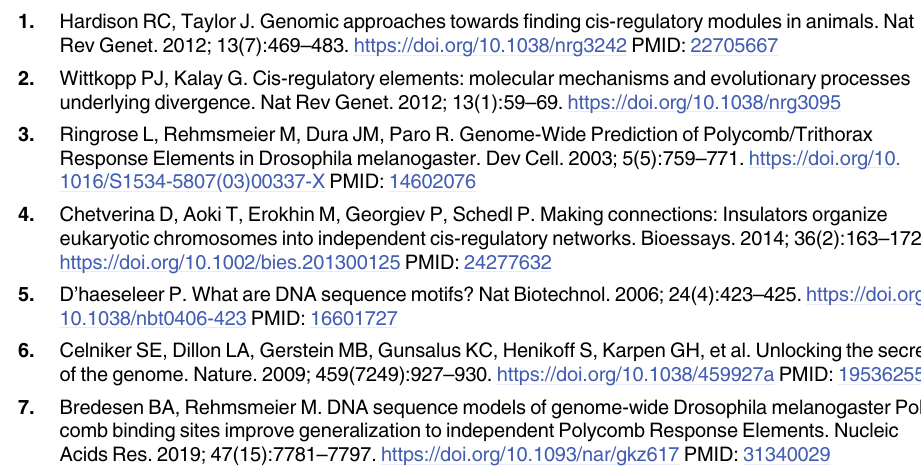
S1 Fig. Training with dummy PREs as negatives leads to overfitting to the training classes. Shown are the dummy PREdictor, the PyPREdictor trained with PREs (positives) and dummy PREs (negatives), a quadratic 5-spectrum mismatch kernel SVM trained with PREs (positives) and genomic non-PREs (negatives) and finally a quadratic 5-spectrum mismatch kernel SVM trained with PREs (positives) and dummy PREs (negatives). Models were tested with A) PREs versus dummy PREs, B) PREs versus coding sequences and C) PREs versus genomic non- PREs. AUC is high for the SVM trained with dummy PREs when tested with dummy